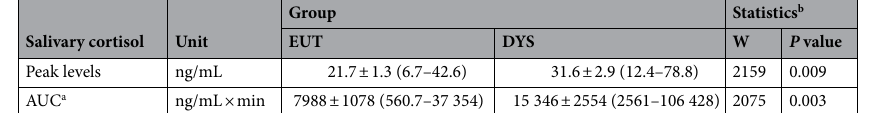
Table 2. Peak levels of salivary cortisol concentrations and salivary cortisol concentrations calculated as area under the curve (AUC) of newborn calves born from eutocic (EUT, n = 98) and dystocic (DYS, n = 70) deliveries. Descriptive statistics are based on means ± SEM (ranges) of non-transformed data. a Area under the curve was calculated for the first 48 h after delivery. b Statistical significances for response parameters of the HPA axis are based on results from the Wilcoxon rank-sum test with continuity correction. W = Wilcoxon value; the sum of the ranks in one of both